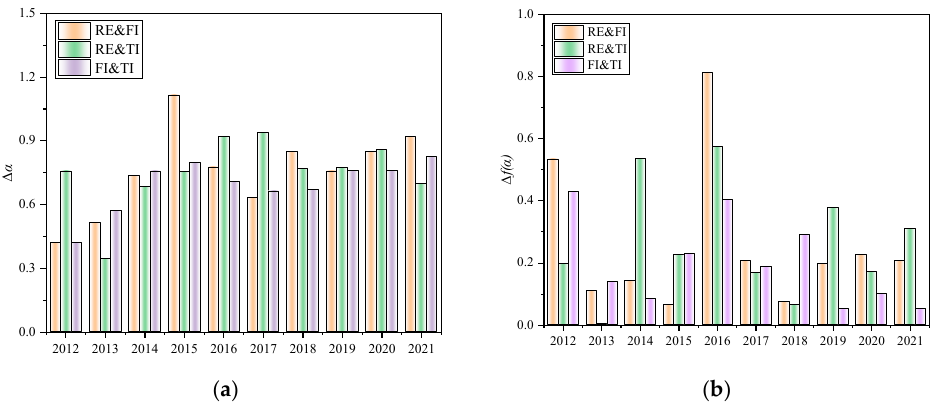
Figure 8. Time-varying analysis of multifractal-spectral parameters. ( a ) Width difference of fractal spectrum. ( b ) Height difference of fractal spectrum.